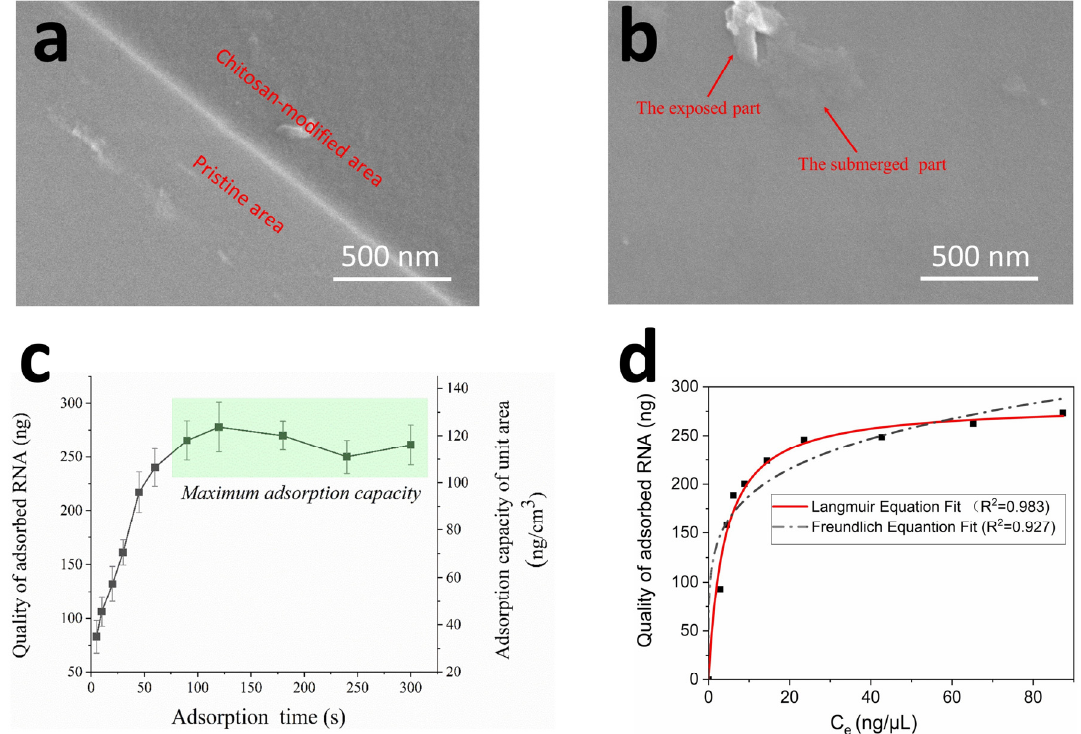
Figure 5. ( a ) The boundary between the modified area and unmodified area on the capillary surface; ( b ) Inner surface of chitosan-modified capillary, a granular substance lay on the surface of the modified capillary and the lower half of the particle appears submerged in a layer of gel (the submerged part), with the top half of the particle exposed outside (the exposed part), indicating that the form of chitosan modified on the capillary was a successive gel-like film; ( c ) Capacity of RNA separation at different times; ( d ) The Freundlich and Langmuir fits for experimental adsorption data of RNA.